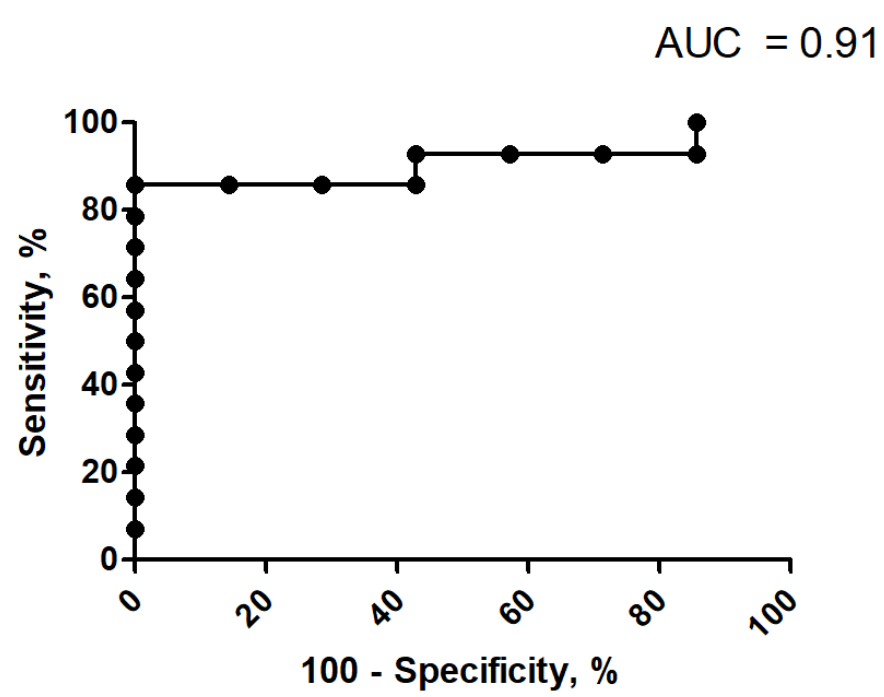
Figure 5. ROC graph for the discrimination analysis of pNET with a Ki-67 threshold of 2%. Kurtosis reached an AUC of 0.91 with a sensitivity and specificity of 0.86 employing the threshold value of 0.30.